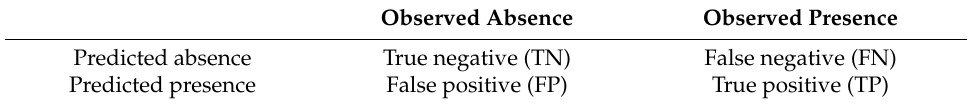
Table 4. Contingency table for presence-absence predictions and selected associated accuracy